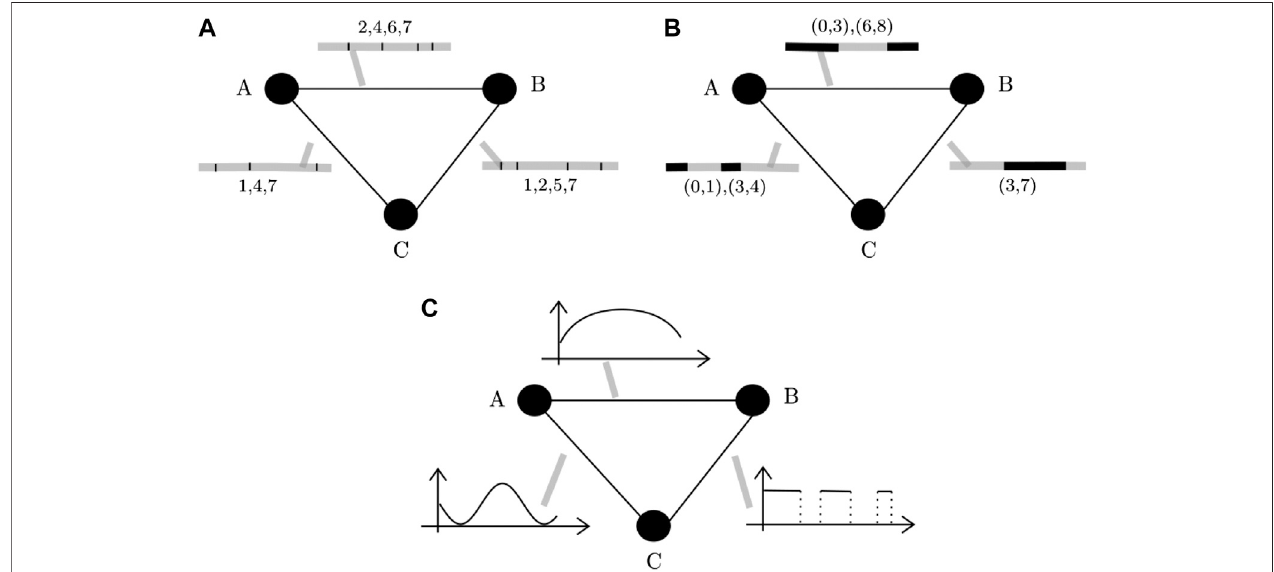
FIGURE 1 | Types of temporal networks: The time of activation is indicated within the grey bar next to the edges (ranging between 0 and 8). For contact networks (A) ,edgesactivate onlyforoneinstant atthetime and aremarkedwithblackvertical lines insidethegrey bars.Forexample,inpanel (A) ,theedgebetweennodes Aand Bisonlyactiveatinstants2,4,6,and7.Forintervalnetworks (B) ,edgescanbeactivatedduringanintervaloftime.Forexample,theedgebetweenAandBinpanel (B) is active during the time intervals (0, 3) and (6, 8). For contact networks (C) , the edges are quantitatively more or less active across time, and the quantity ofactivity of any edge is described by a temporal